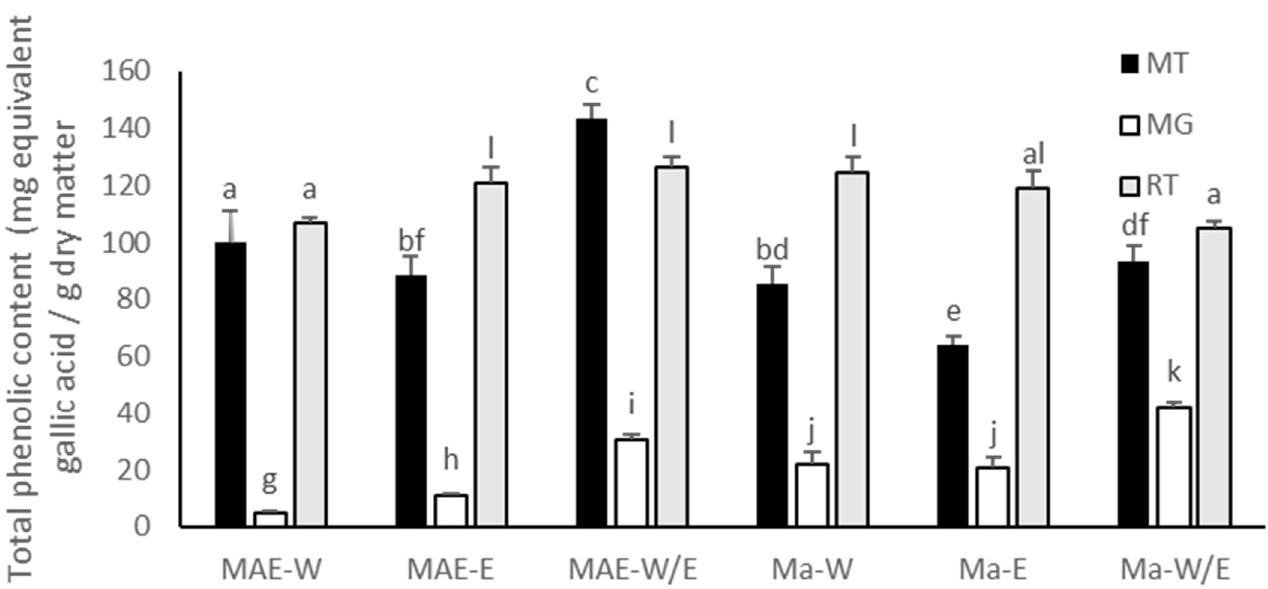
Figure 1. Total phenolic content of extracts in mg equivalent gallic acid/g dry matter: mangosteen peel (MT); mango peel (MG); rambutan peel (RT); microwave-assisted extraction (MAE); maceration (Ma); water (W); ethanol 95% (E); water–ethanol (40:60%) (W/E). The data was performed in term of Mean ± S.D. Different letters (a–l) indicate a significant difference ( p < 0.05) between each bar.